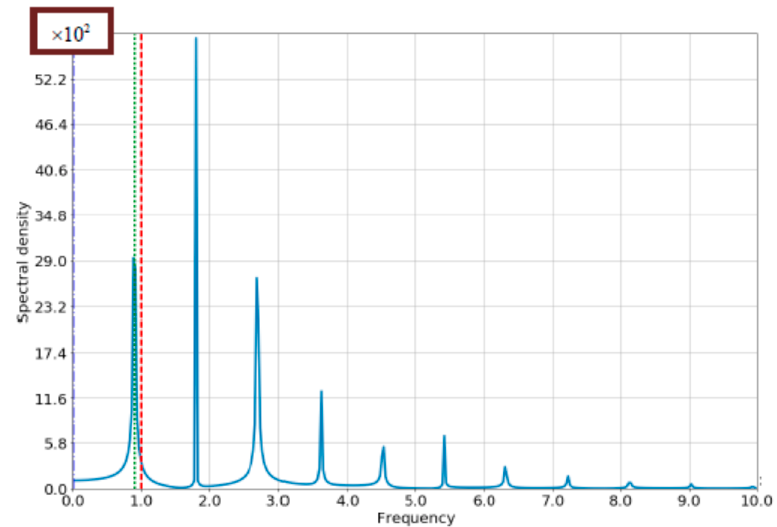
Figure 21. The frequency spectrum of tunneling current density with Stark effect. All parameters are identical to Figure 15.